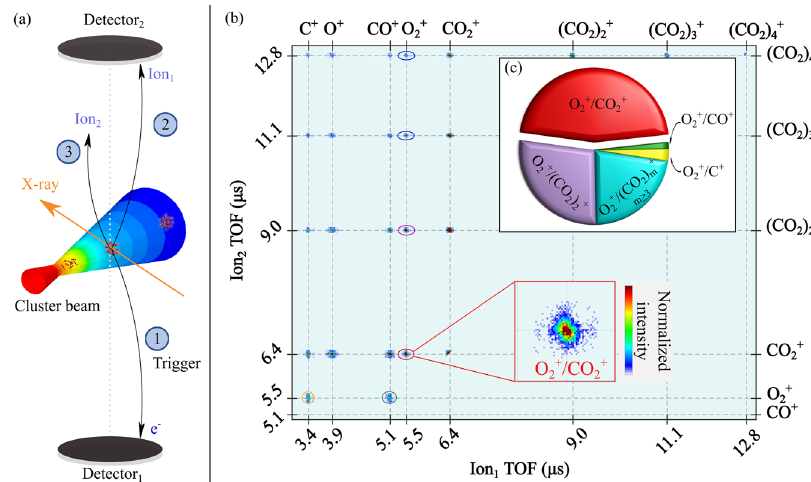
Fig. 1 Principle of the measurement. a Schematic of the experiment showing a typical double-ion coincidence measurement. After ionisation, the detection of an electron, Detector 1 , triggers the acquisition system and the arrival time-of- fl ight (TOF) of the ions and their positions are recorded on Detector 2 , allowing us to determine the momentum of individual ions. b Two-dimensional coincidence map of Ion 1 TOF vs Ion 2 TOF produced following ionisation of CO 2 clusters ( N mean ~ 20) at 320 eV. The data is fi ltered to remove false coincidences. The cluster dissociation channels are shown, together with an expanded view of the O þ /CO þ channel. c Pie chart indicating the dissociation channels that lead to O þ 2 2 þ = C þ channel. In free CO = C þ is the only channel that can produce O þ the O þ 2 molecules, O 2 2 = ð CO Þ þ m = 1, 2, . . . , dominating O þ m channels ( 2 2